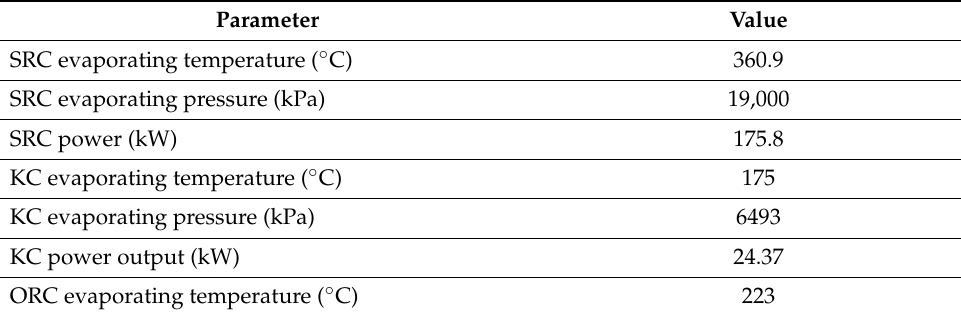
Table 8. Simulation results for SRC, RC and